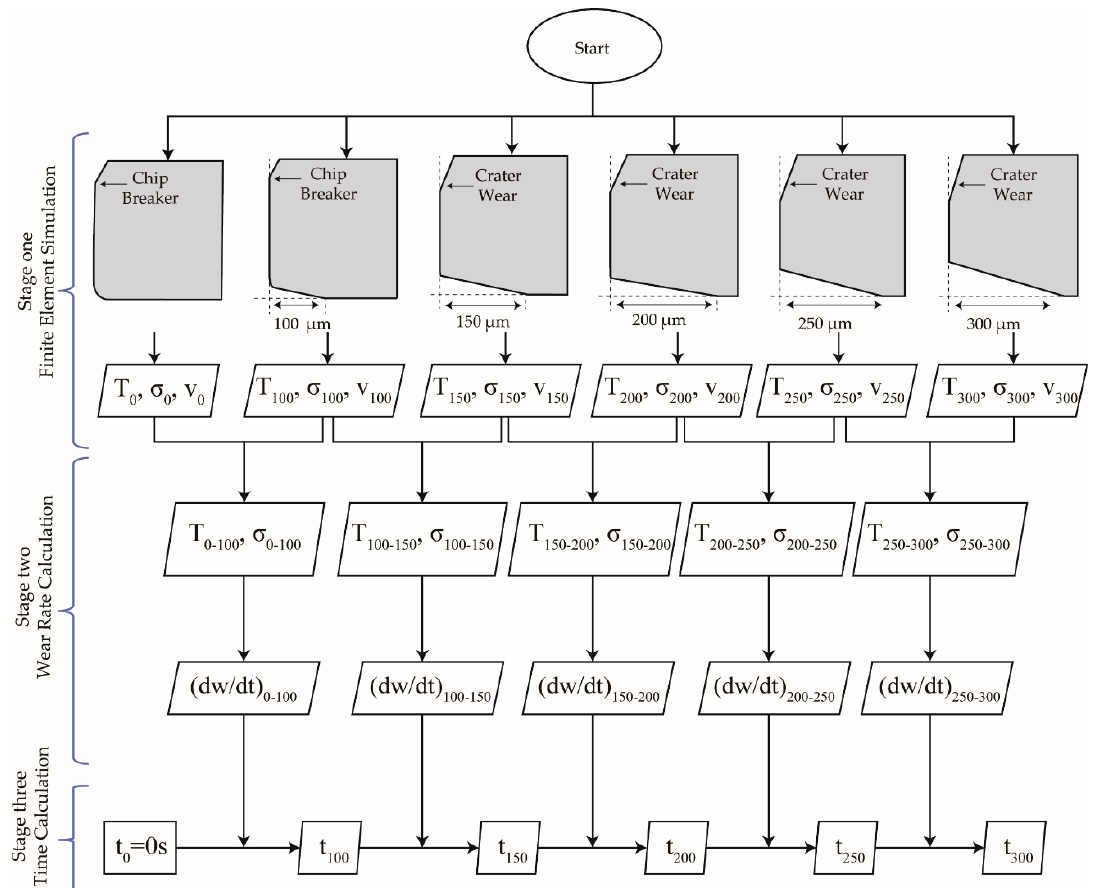
Figure 6. Overall procedure of the proposed methodology.